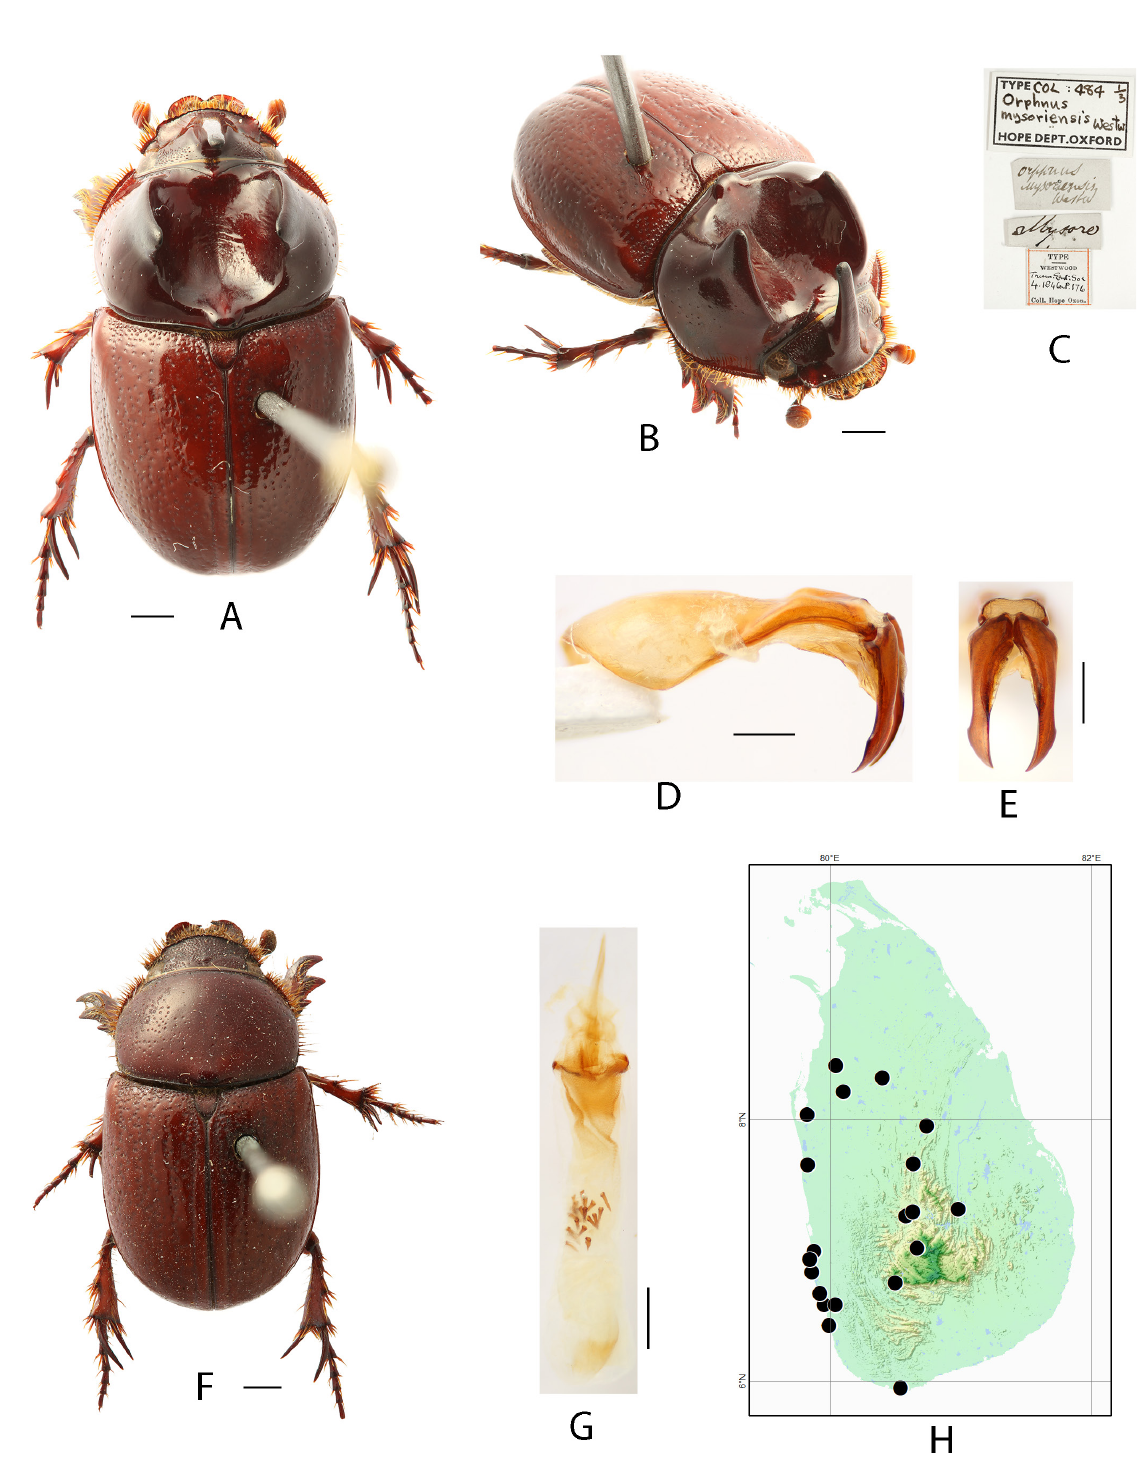
Fig. 1. Orphnus mysoriensis Westwood, 1845. A–E , G . Lectotype, ♂ (OUM). F . Paralectotype, ♀ (OUM). A–B , F . Habitus in dorsal view. C . Labels. D . Aedeagus in lateral view. E . Parameres in dorsal view. G . Endophallus. H . Distributional record map. Scale bars: A–B, F = 1.0 mm; D–E, G = 0.5